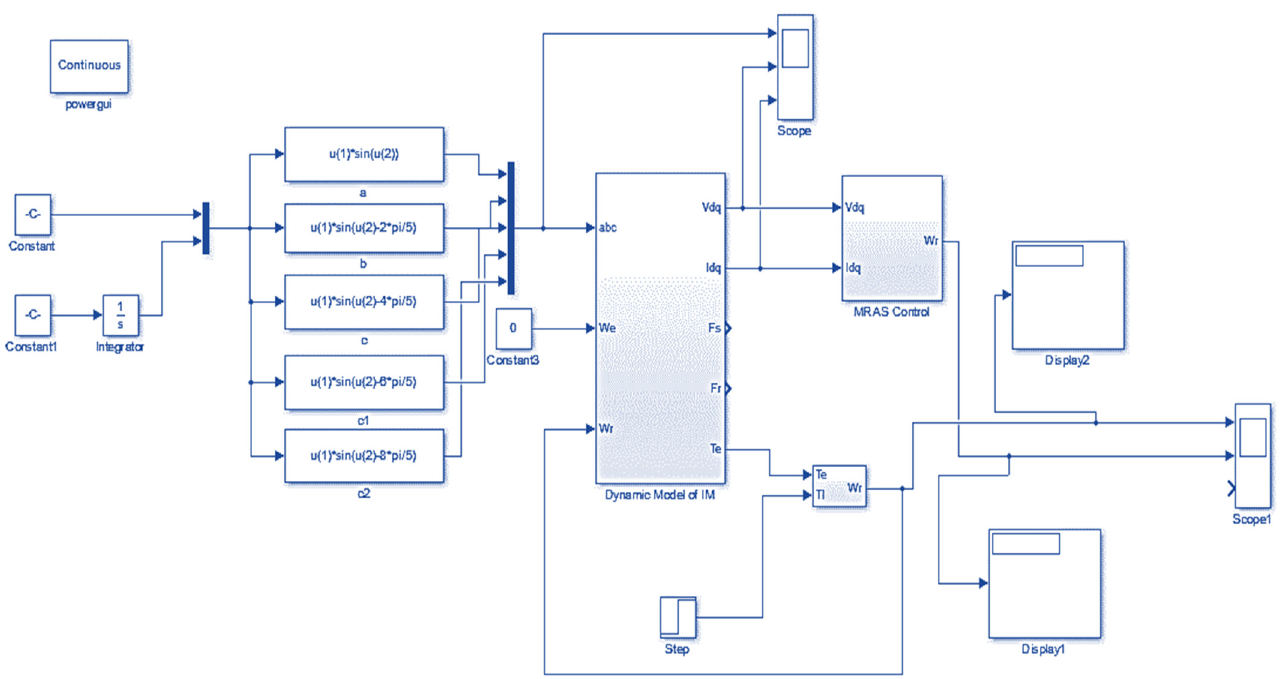
Figure 18. Model reference adaptive system and control.